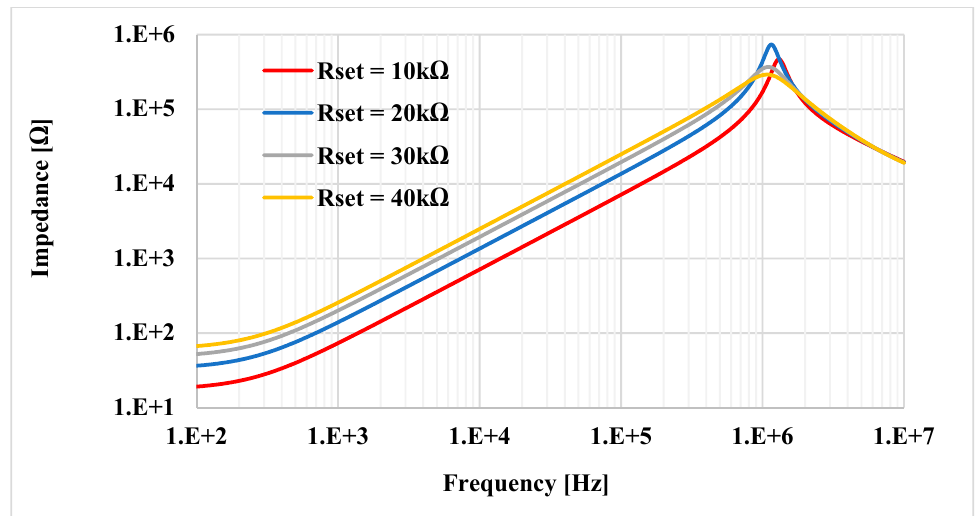
Figure 19. The frequency and phase responses of the lossless L connection with R set = 10 k Ω .